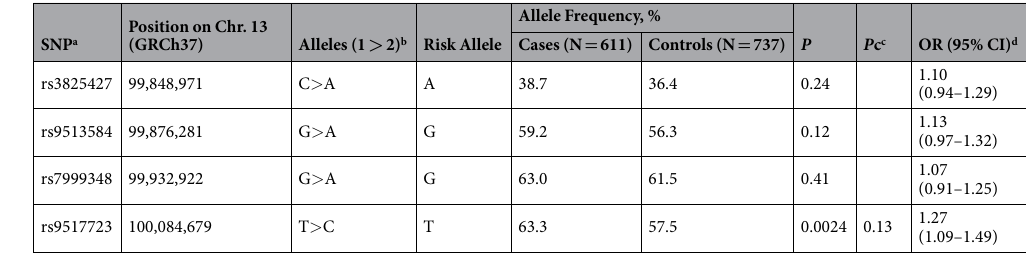
Table 1. Allelic association results for rs3825427, rs9513584, rs7999348, and rs9517723 in the UBAC2 region. a rs9513584, rs7999348, and rs9517723 were genotyped on the GWAS panel while rs3825427 was imputed with the 1000 Genomes reference panel. b 1, major allele; 2, minor allele. c P c, corrected P ; If the P c value is greater than 1, it is set to 1. d OR, odds ratio; CI, confidence